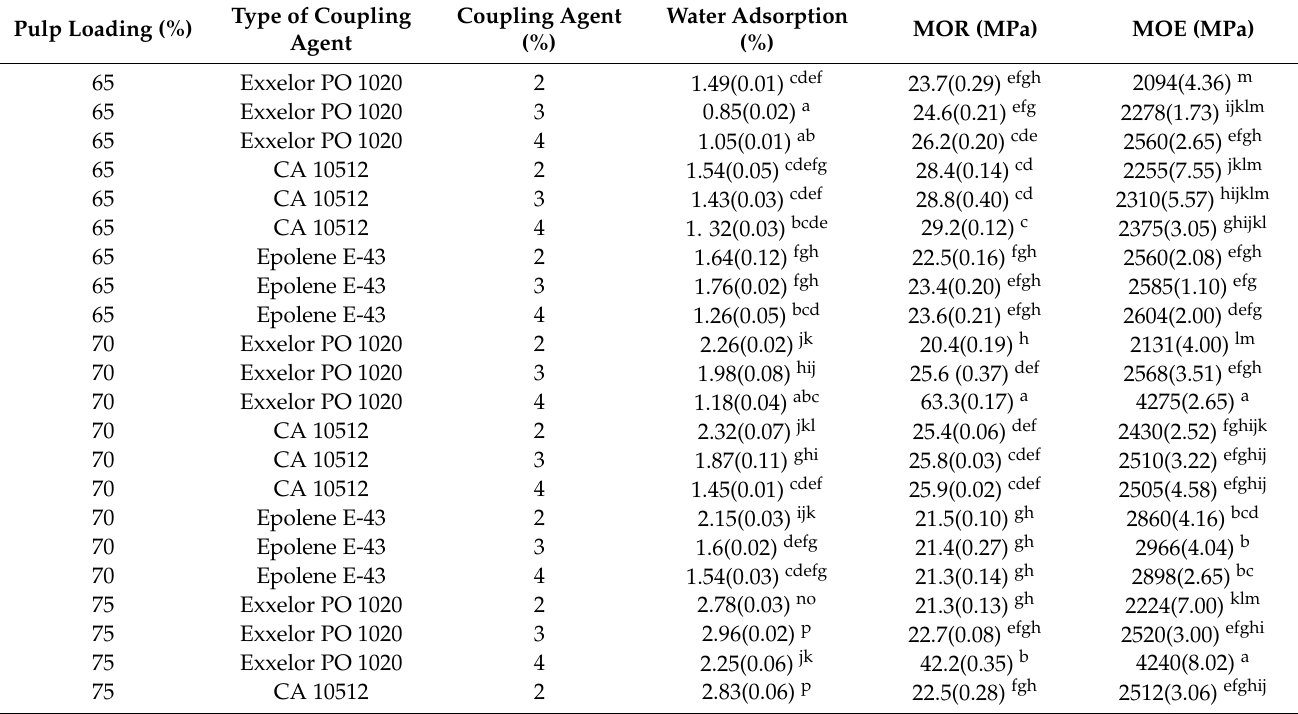
Table 6. Physical and mechanical properties of PP/OPTP composites from different material loading